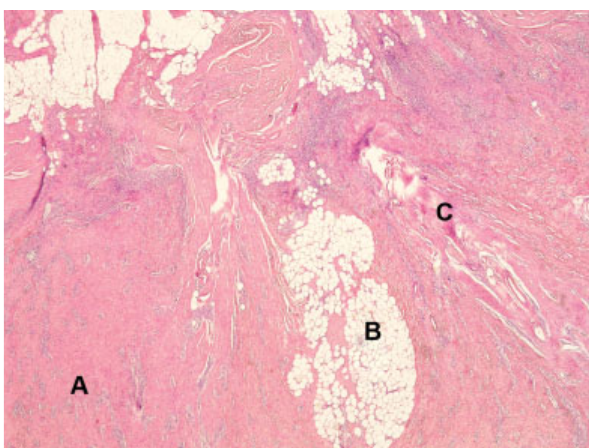
Fig. 5 Electron microscope increased (cid:3) 20 hematoxylin and eosin stain; characteristic components — fi brous connective tissue ( A ), islands of mature fat cells ( B ), and mesenchymal stroma ( C